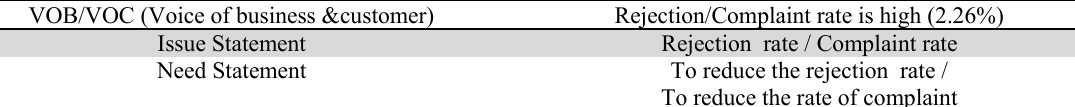
Analysis of business